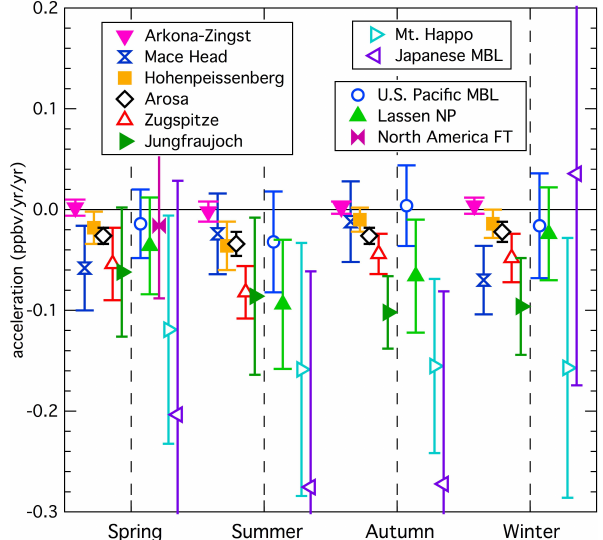
Fig. 8. Summary of the acceleration parameter derived from the quadratic regressions to the eleven northern mid-latitude data sets in each season. The acceleration, with units of ppbvyr − 2 , is defined in Eq. (2) of the text, and represents the average rate of increase of the slope over the period of the data